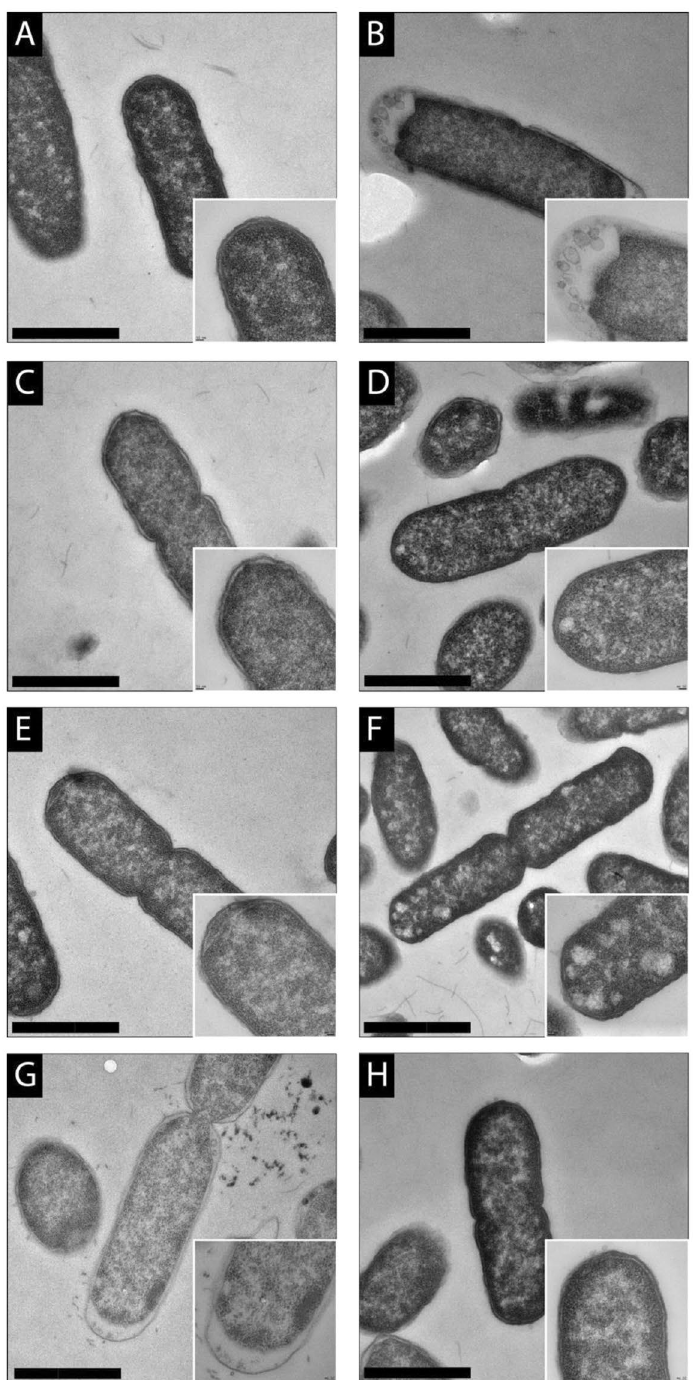
Figure 4. TEM micrographs of resin-embedded thin sections of STEC 86–24 following treatments with ( A ) no treatment (control) ( B ) peptide (128 μ g/mL) ( C ) kanamycin (16 μ g/mL) ( D ) gentamicin (4 μ g/mL) ( E ) kanamycin (4 μ g/mL) and peptide (8 μ g/mL) (F) kanamycin (4 μ g/mL) and peptide (4 μ g/mL) ( G ) gentamicin (0.25 μ g/mL) and peptide (32 μ g/mL) ( H ) gentamicin (1 μ g/mL) and peptide (16 μ g/mL). Scale = 1 μ m. These images are representative of images collected on two different